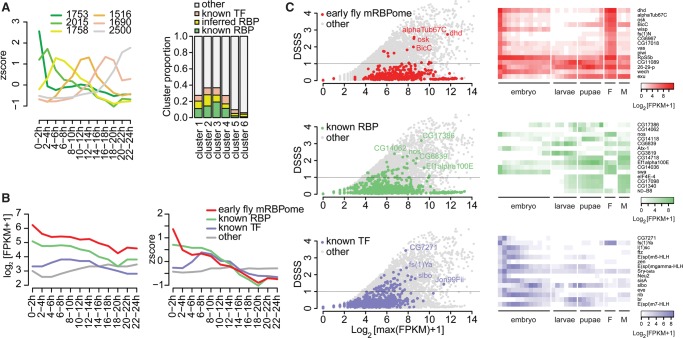
RBP expression in Drosophila development. (A) Clustering of z-score-transformed gene expression levels of protein-coding genes expressed during embryogenesis (0–24-h post egg laying) (n = 11,232) (Graveley et al. 2011) into six condensed, timely resolved clusters. (Left) Cluster median z-score-transformed expression values over time. Clusters sizes are indicated in order 1 through 6. (Right) Cluster proportions of all known RBP (harboring RBDs or RNA-binding GO annotation), inferred RBPs (as described in Fig. 2D), and known TFs (FlyTF.org). (B) Median of absolute expression values (log2[FPKM + 1]) and relative expression values (z-score) of the early embryo mRBPome without ribosomal proteins, known RBPs without ribosomal proteins, and known TFs over time during embryogenesis. (C) Developmental Stage Specificity Score (DSSS) for genes expressed during 30 developmental stages (Graveley et al. 2011) for all protein-coding genes (n=13,452). Scatterplot of DSSS relative to log2-transformed maximal expression levels for the indicated subsets (left) and heat map of log2-transformed FPKM + 1 expression values of the 15 most specific members of each subset.